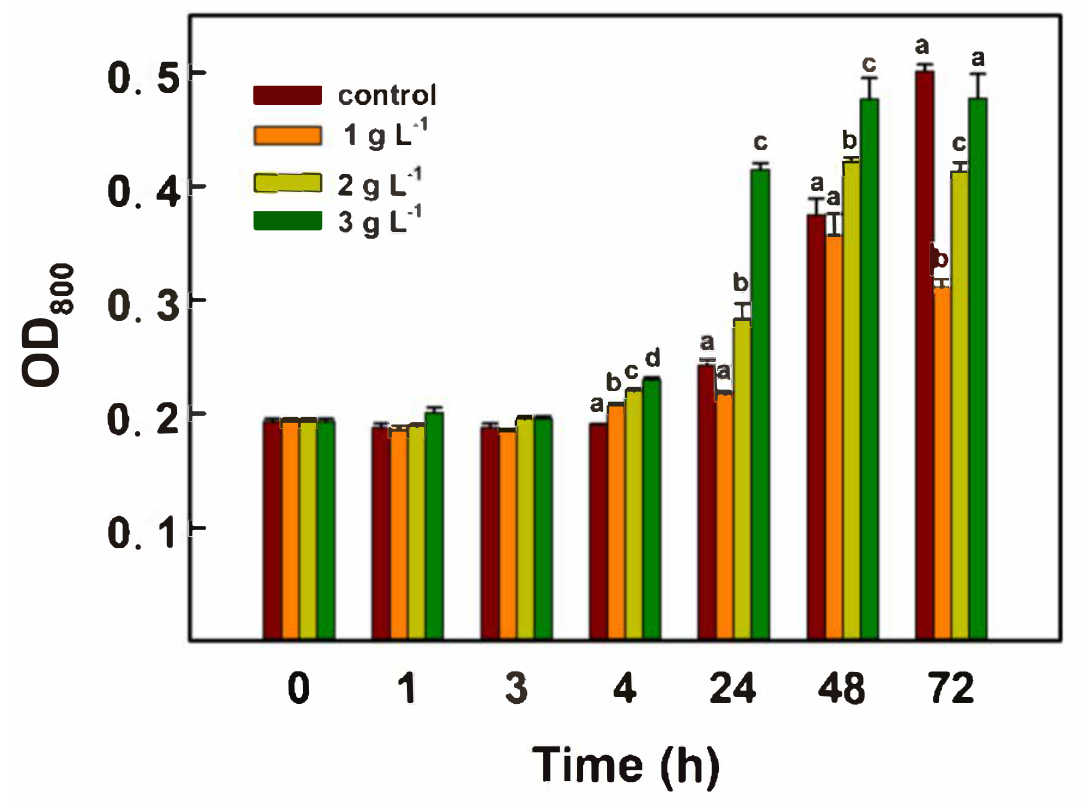
Figure 1. Chlorella sorokiniana growth determined by optical density (OD 800 ) estimation in control cells and after di ff erent bicarbonate addition NaHCO 3 1 g L − 1 , 2 g L − 1 , and 3 g L − 1 . Error bars represent SD ( n = 3). The values with the same letter were not significantly di ff erent ( p ≤ 0.001, ANOVA, Tukey’s multiple